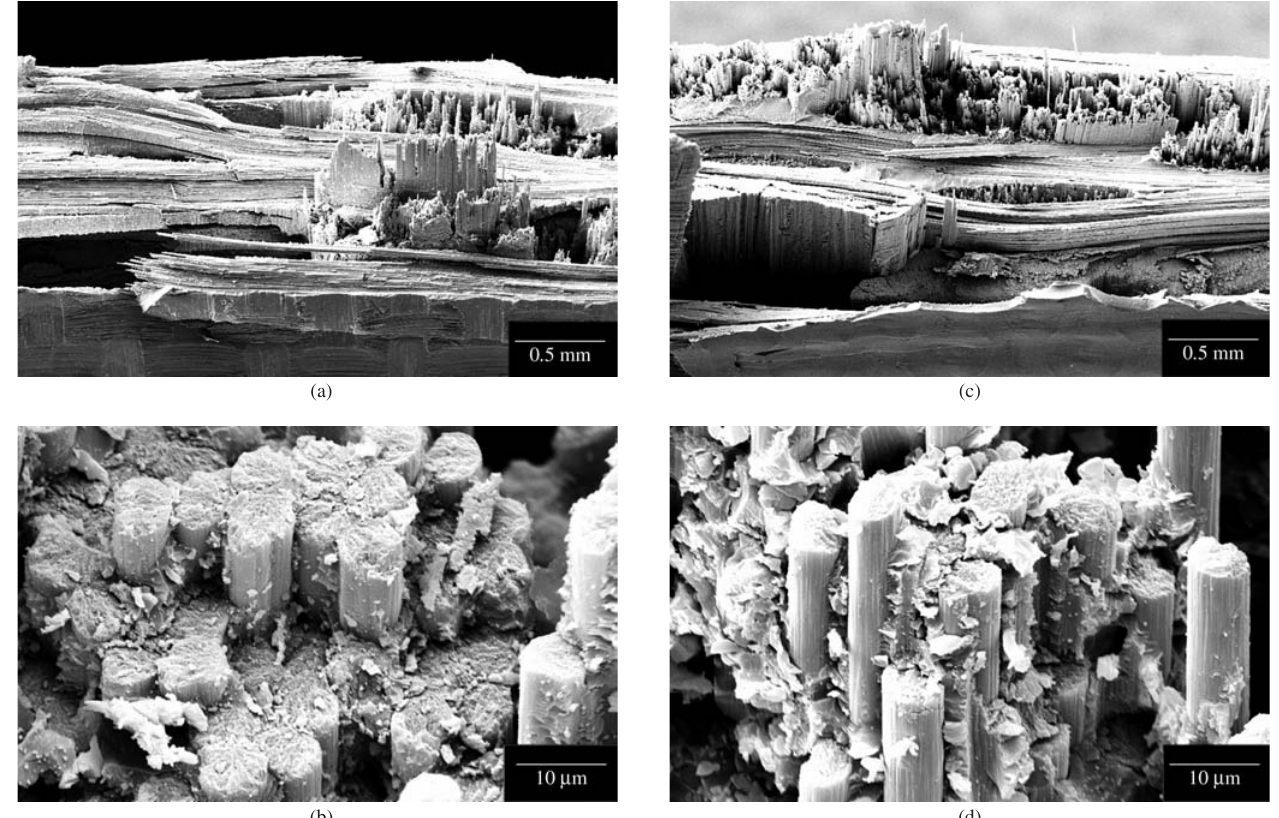
Figure 6. SEM-fractographs of specimens fractured under impact loading: a,b) Maximum dynamic toughness exhibited by fiber fabric configuration (FB180) tested under 50 Joules; and c,d) Minimum impact resistance displayed by fiber fabric array (FB120) tested under available energy of 5